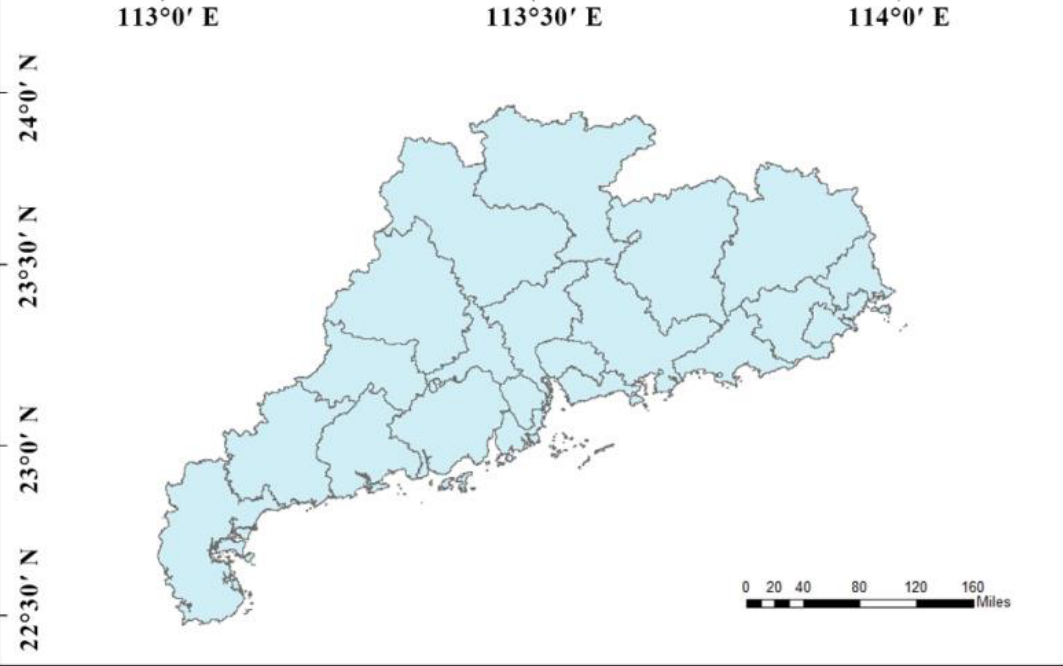
Figure 1. Guangdong Province.